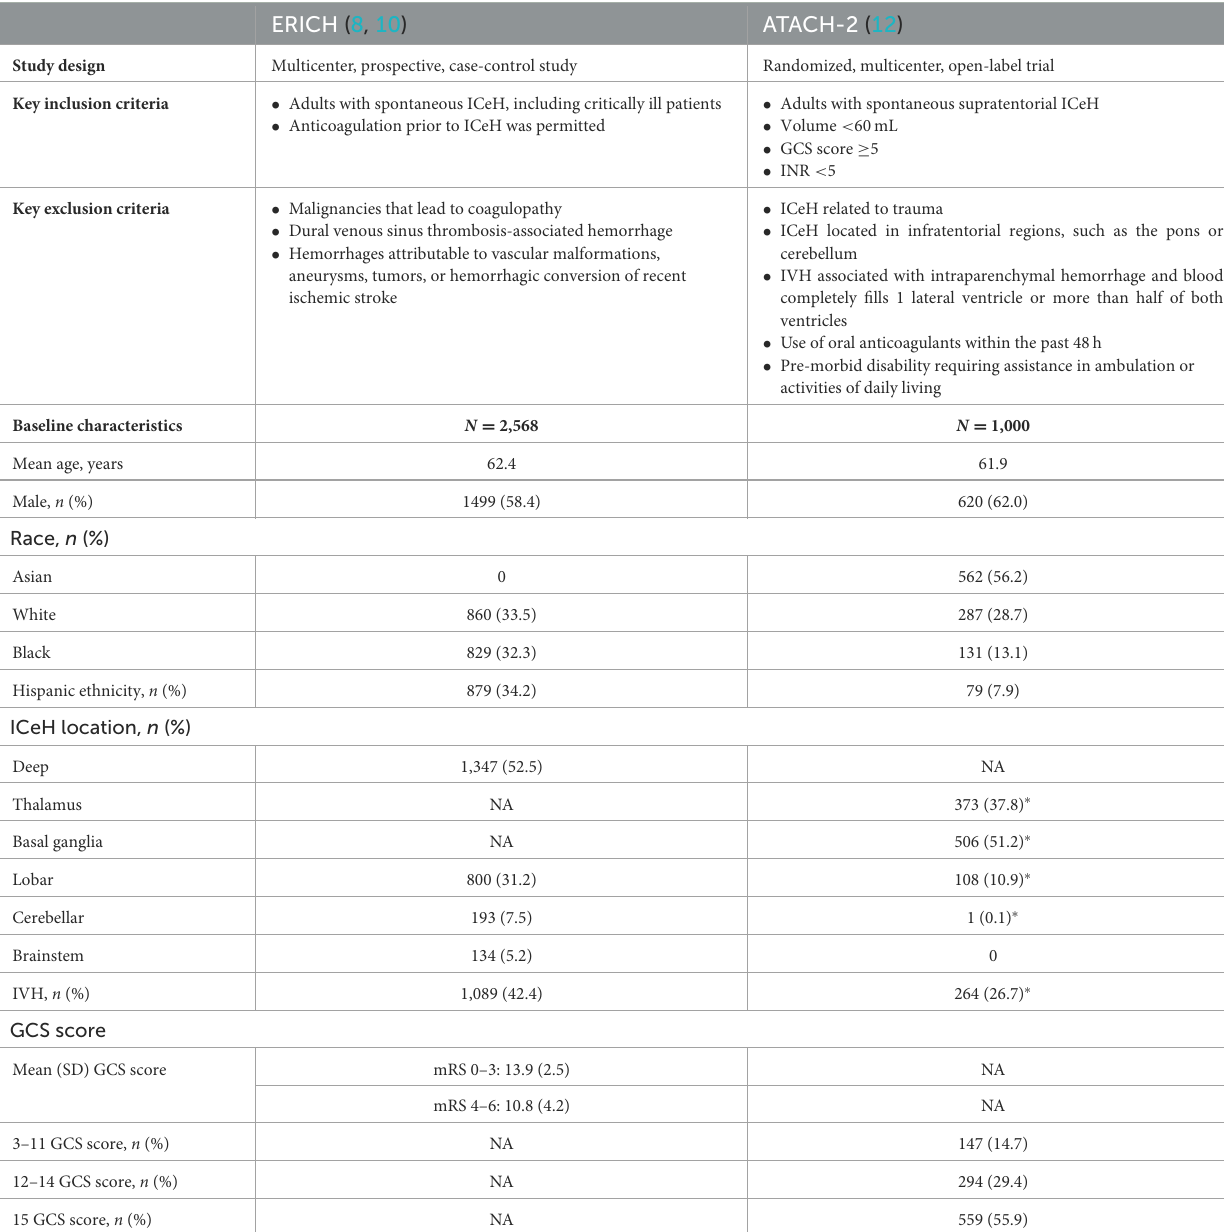
TABLE 1 Summary of the ERICH and ATACH-2 study designs and overall patient populations. ERICH (8, 10) ATACH-2